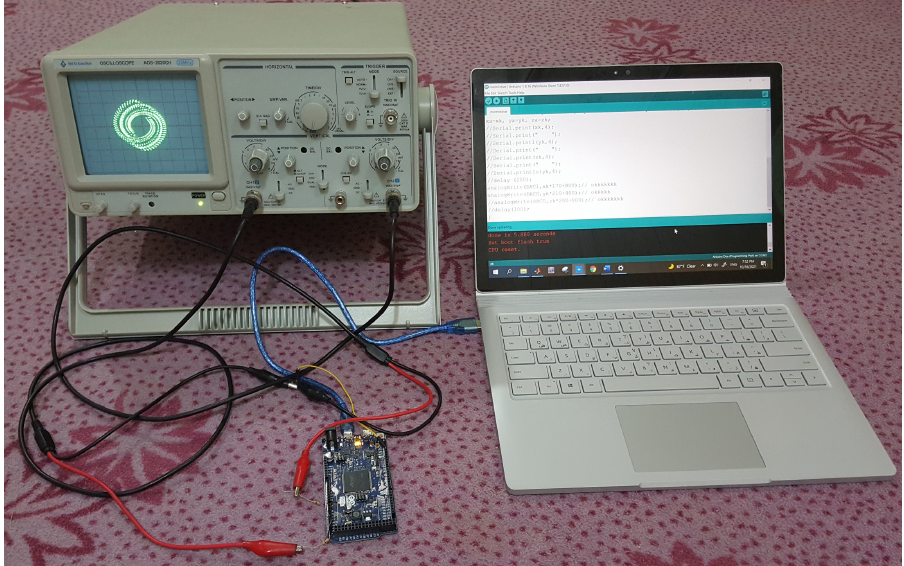
Figure 13. The hardware setup for implementing the new fractional-order memristive chaotic system via a microcontroller (Arduino Due).